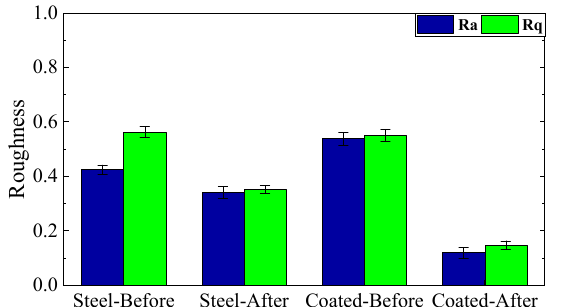
Figure 6. Roughness before and after running-in test.